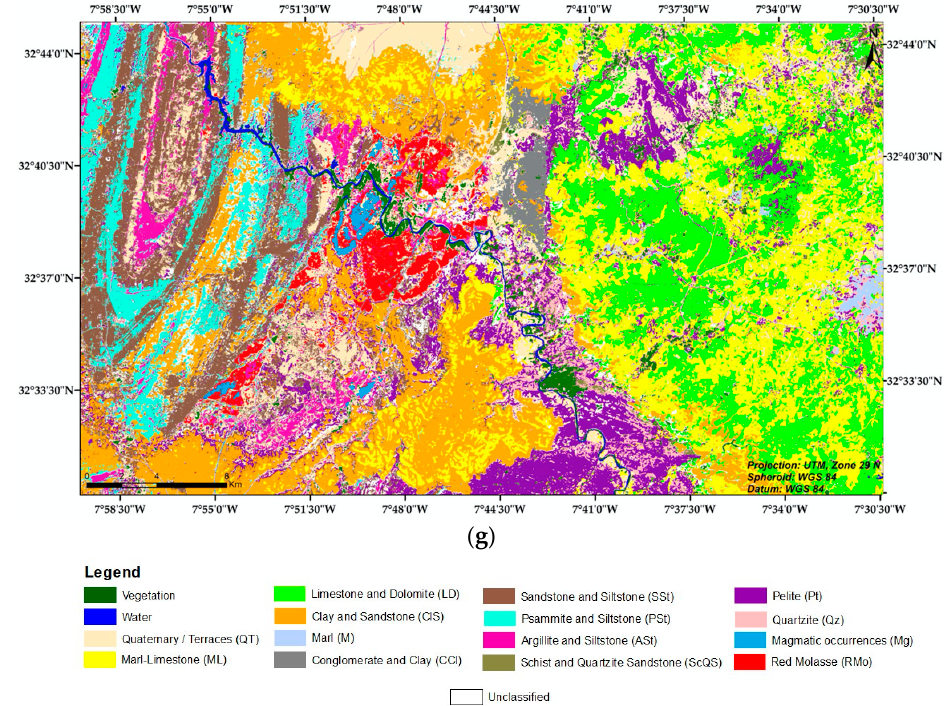
Figure 6. ( a ) Location of the training samples polygons superposed on the RGB color composite generated with the PC2, MNF1 and MNF3 bands. Lithological maps of the study area by: ( b ) random forest (RF); ( c ) support vector machine (SVM); ( d ) classification regression tree (CART); ( e ) minimum distance (MD); ( f ) naïve Bayes (NB); ( g ) using the proposed approach.